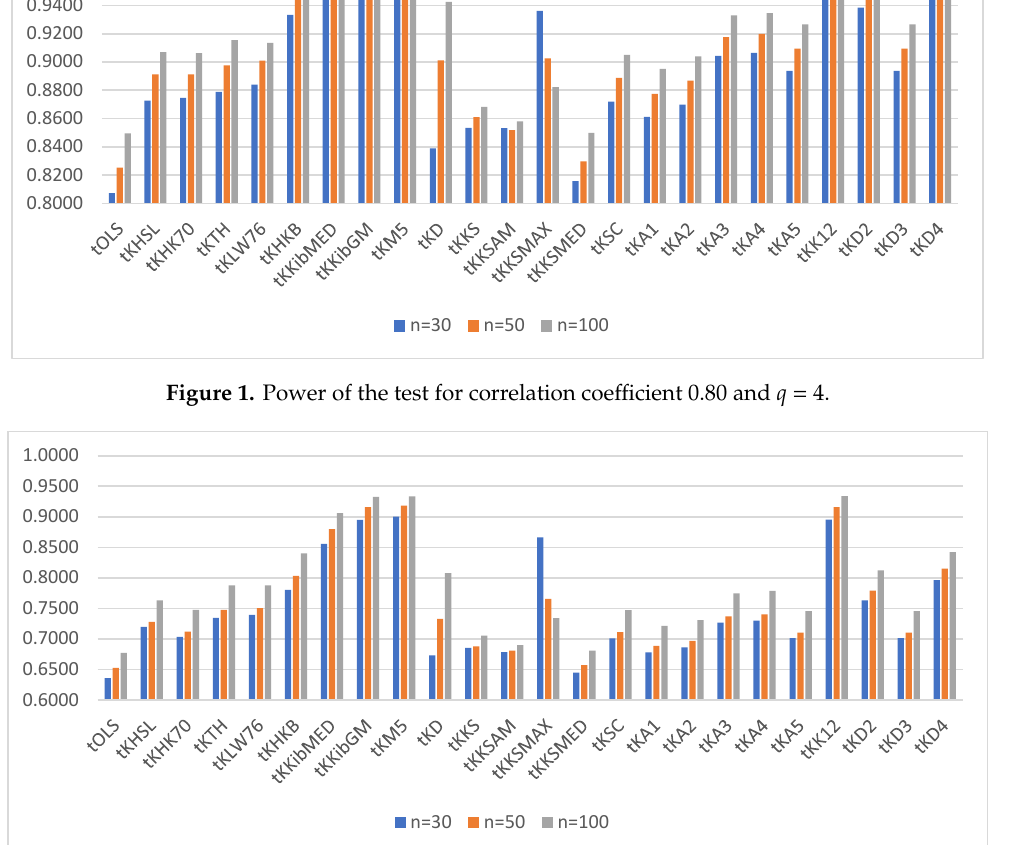
Figure 2. Power of the test for correlation coefficient 0.80 and q = 6.